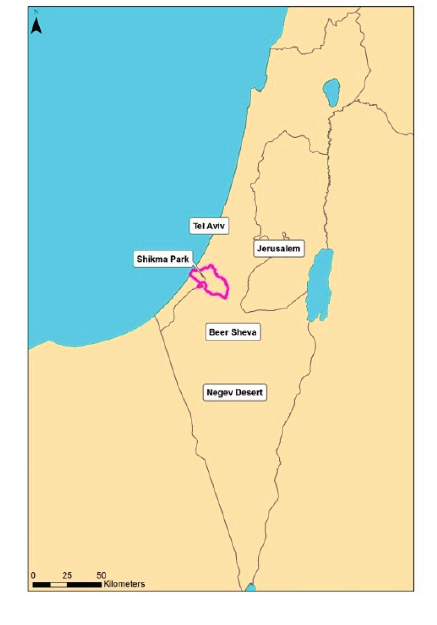
Figure 1. Shikma